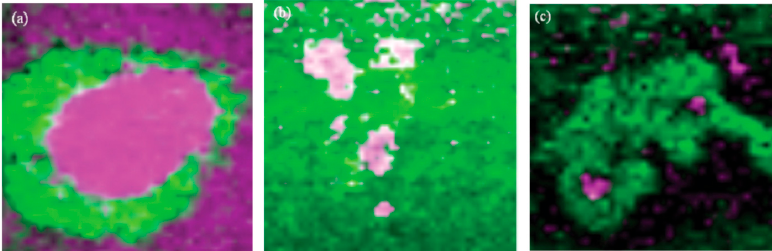
Figure 16. (Color online) Raman images of brass exposed 1 month to humidified air with formic acid ( a ); acetic acid ( b ); or propionic acid ( c ). The formation of Zn-carboxylate is represented by pink and of Cu 2 O by green. Scan size 10 × 10 μ m. Reproduced from reference [61] by permission of The electrochemical Society. Copyright 2010.